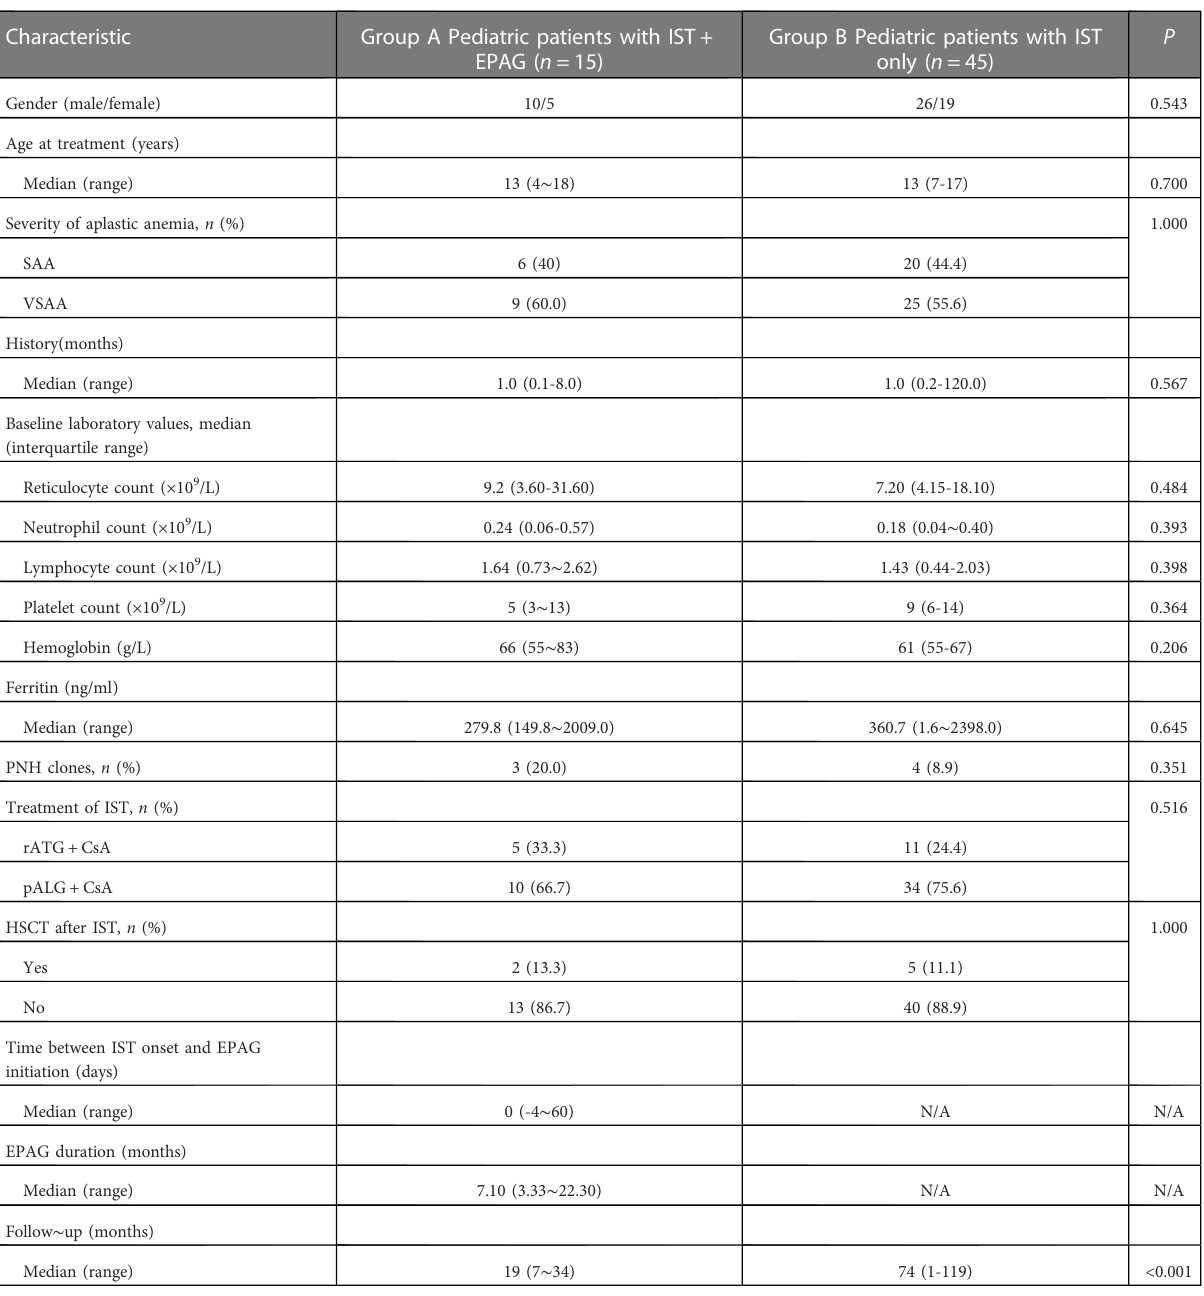
TABLE 1 Baseline characteristics of the patients. Characteristic Group A Pediatric patients with IST +